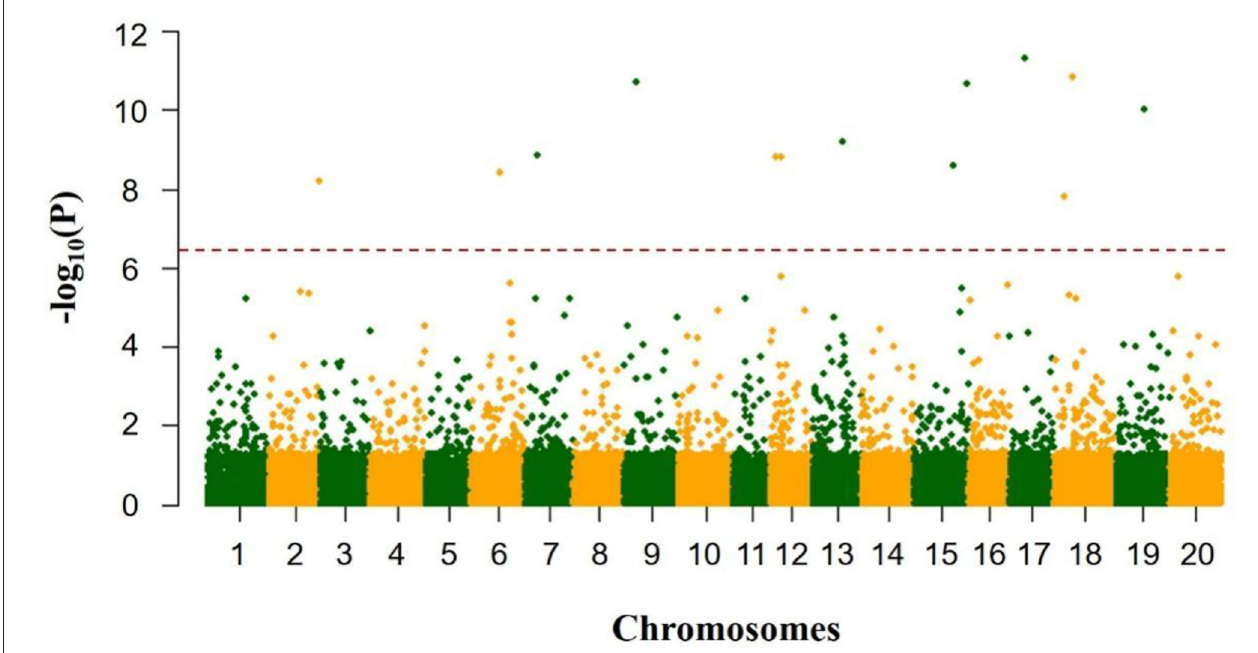
FIGURE 4 | GWAS results of total soluble sugar content from 278 soybean accessions.